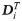
Architecture of a 2-layered SDPC model.In this model, γi represents the activity of the neural population and ϵi is the representation error (also called prediction error) at layer i. The synaptic weights of the feedback and feedforward connection at each layer (DiT and Di respectively) are reciprocal. The level of sparseness is tuned with the soft-thresholding parameter λi. The scalar kFB controls the strength of the feedback connection represented with a blue arrow.